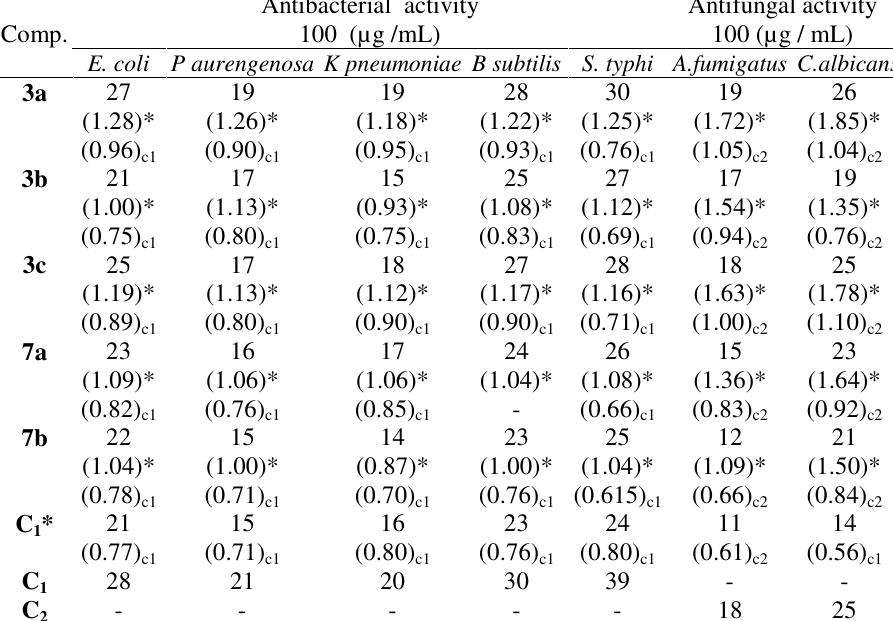
Table 2 . Anti-microbial activity of synthesized compound 3a-c and 7a-b Zone of Inhibition in (mm) (activity